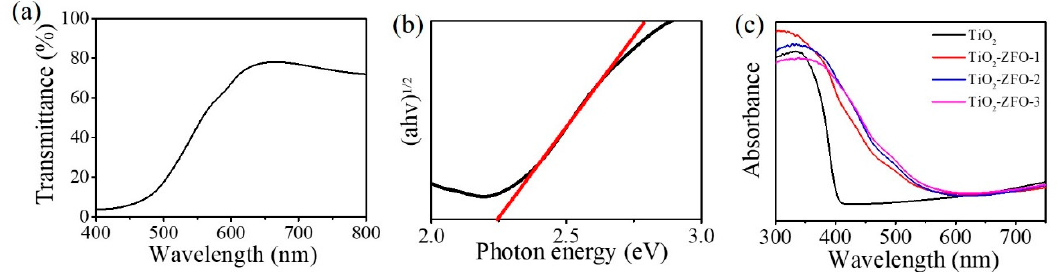
Figure 6. ( a ) Transmittance (%) spectrum of the ZFO thin film. ( b ) Tauc plot of the ZFO thin film. ( c ) Optical absorbance spectra of various nanorods.